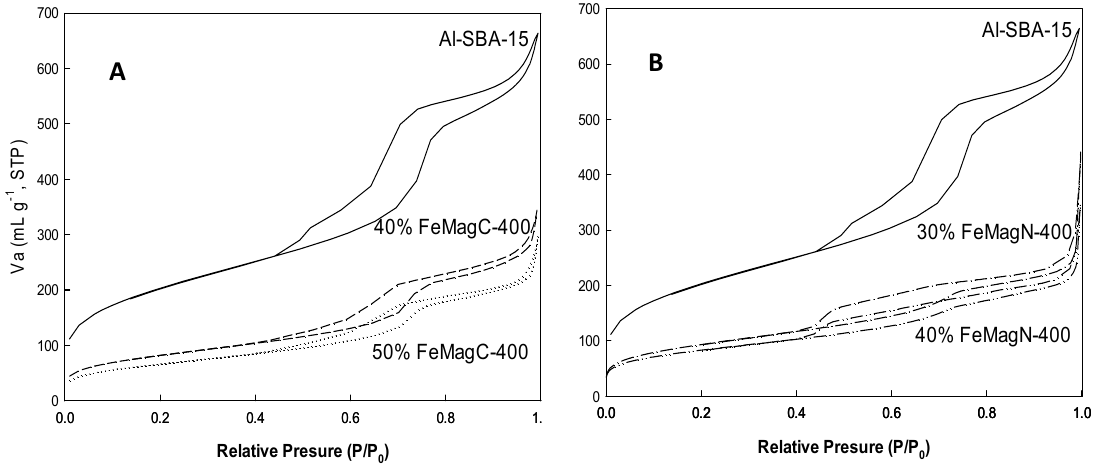
Figure 2. N 2 adsorption–desorption isotherms of (A) FeMagC at 400 °C, and (B) FeMagN at 400 °C. Table 1. Textural properties of the obtained materials. BET—Brunauer–Emmett–Teller; EDX—energy-dispersive X-ray spectroscopy.